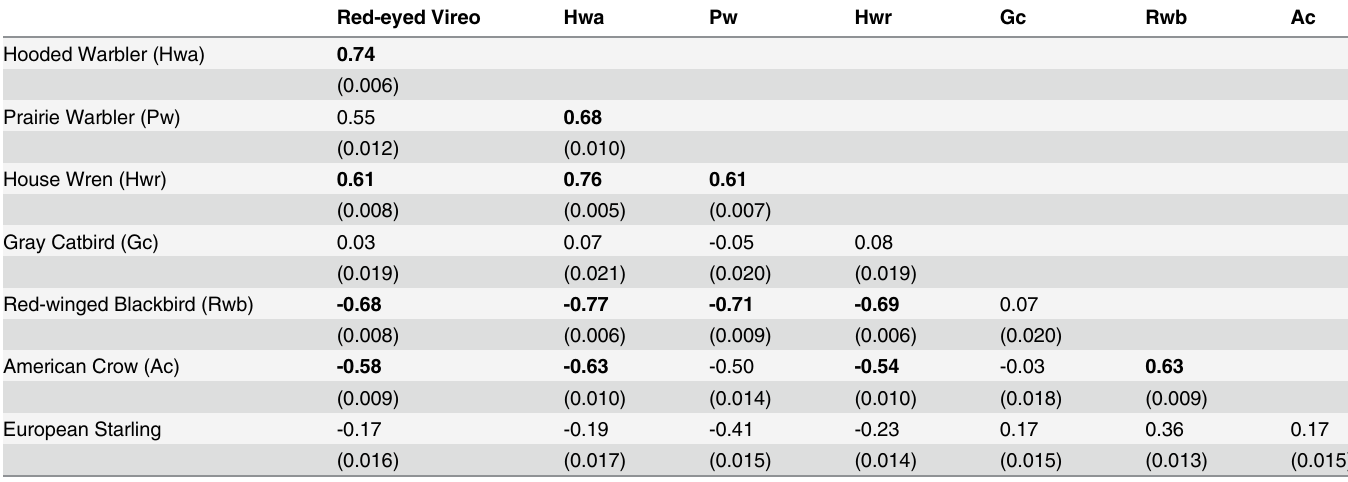
Table 1. Estimated correlations between abundances of avian species fitted to the multispecies N-mixture